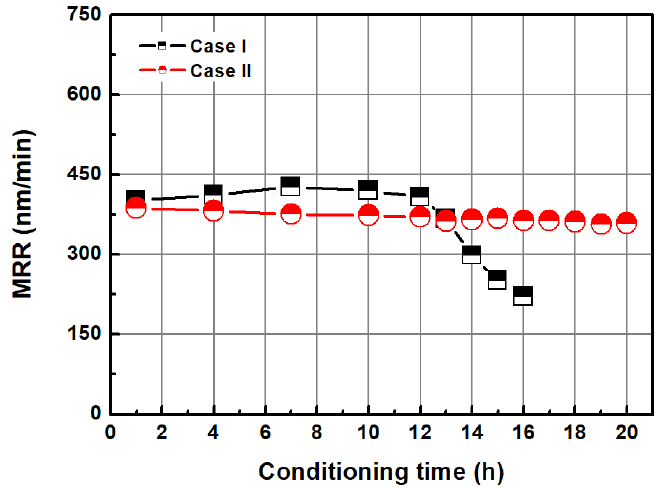
Figure 15. Average material removal rates of Case I and II as a function of conditioning time.